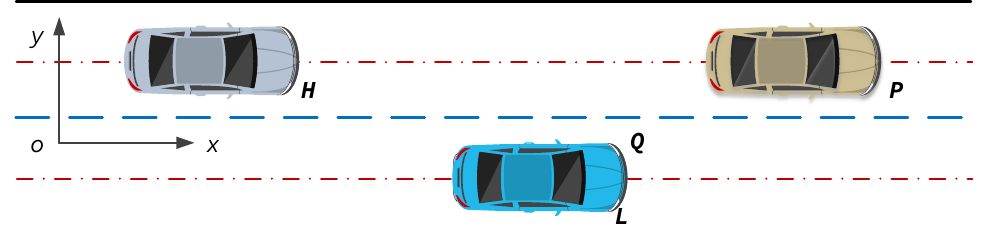
Figure 10. Cut-in scenario. Figure 10. Cut-In